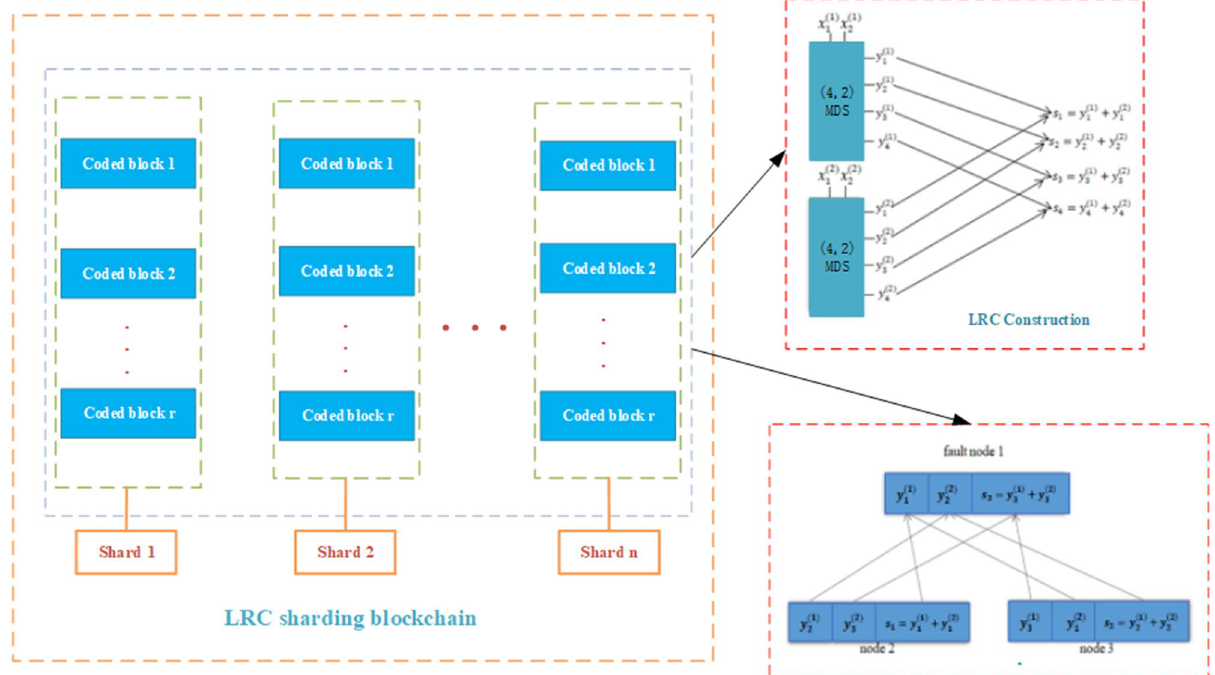
Figure 2. LRC sharding blockchain